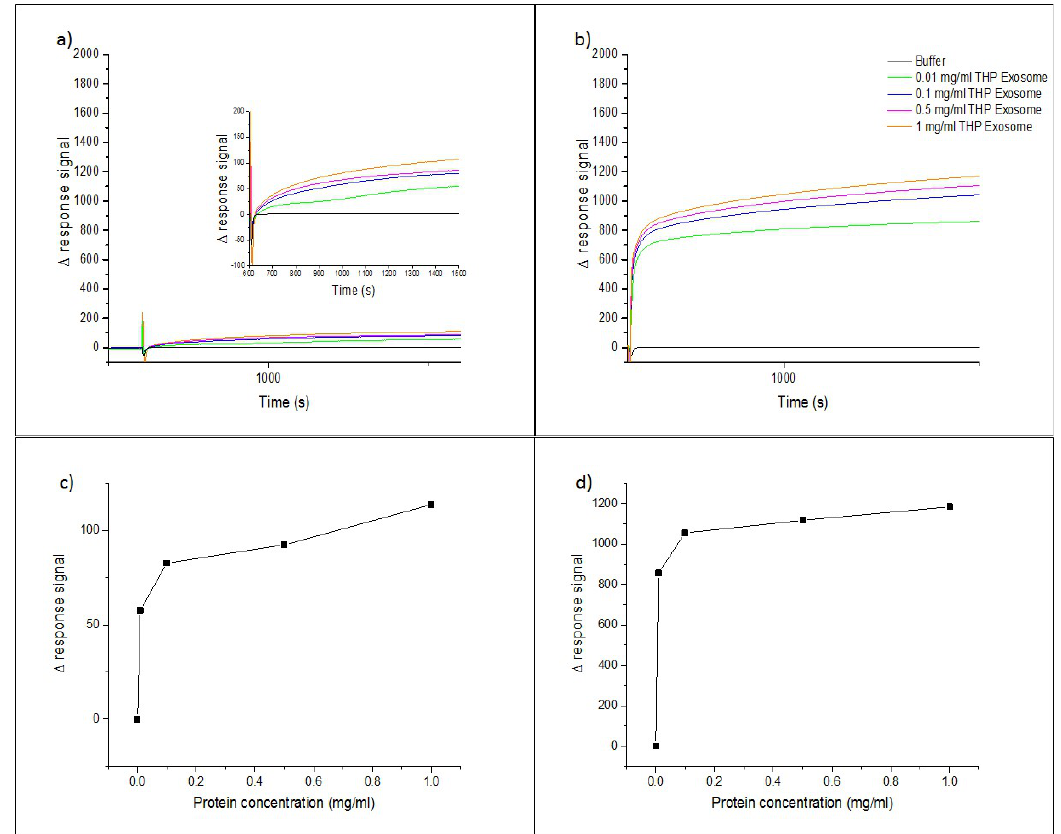
Figure 5. Surface plasmon measurements of the THP-1 derived exosomes using just the antibody ( a ) and the InP/ZnS–Anti-CD63 ( b ). Binding curves of the response of the sensor chip to the binding of the exosomes using the Anti-CD63 ( c ) and InP/ZnS–Anti-CD63 ( d ). For the InP/ZnS–Anti-CD63, the binding shows a steep increase for the lowest protein concentration of 0.01 mg/mL. The higher protein concentrations then increase gradually.